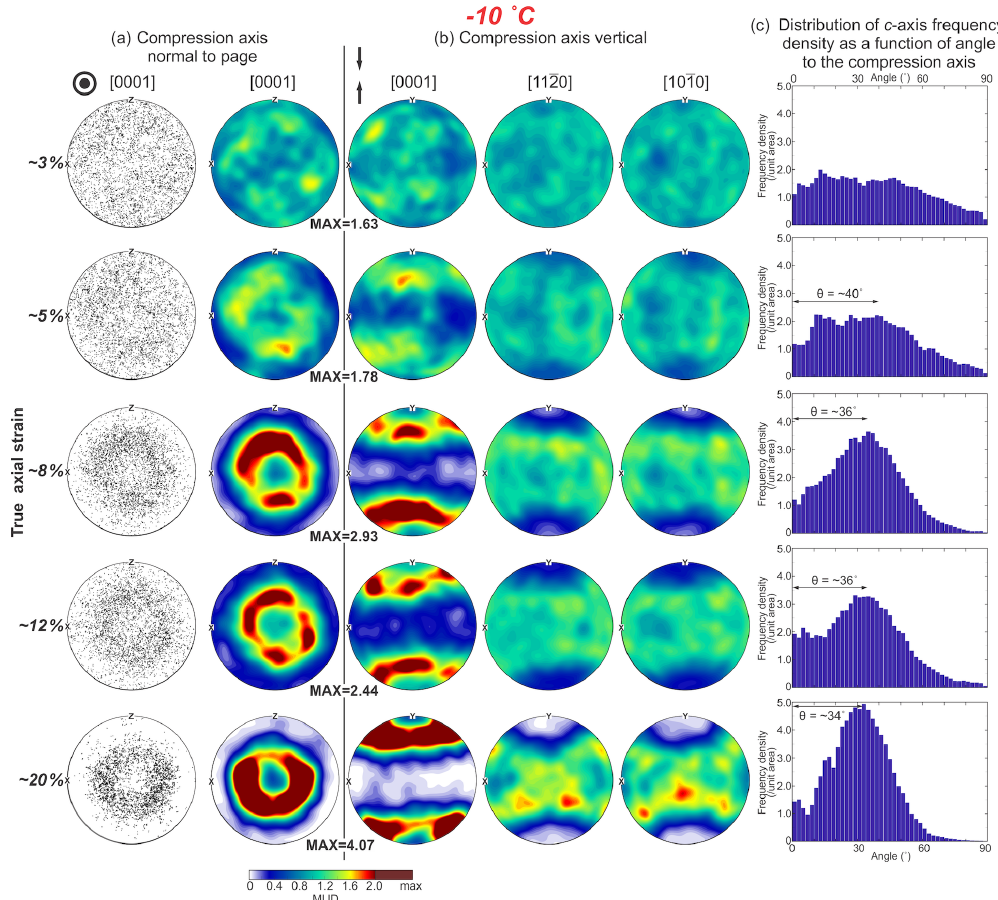
Figure 8. Crystallographic preferred orientations (CPOs) from EBSD data with 30µm step size for ice samples deformed at − 10 ◦ C. Axial true strain increases from ∼ 3% on top to ∼ 20% on the bottom. (a) The distributions of [0001] ( c axes) orientations plotted as point pole figures with 5000 randomly selected points and contoured pole figures. The compression axis is perpendicular to the page. (b) The distributions of orientations for [0001] ( c axes), [11–20] a axes and [10–10] (poles to m planes) plotted as contoured pole figures. The compression axis is vertical. Contoured pole figures are contoured based on MUD. The maximum value of MUD for the c -axis CPO of each sample is given between columns (a) and (b) . (c) Distributions of the [0001] axes frequency density as a function of angle to the compression axis. Open half-angle θ of the cone (small circle) is presented on each